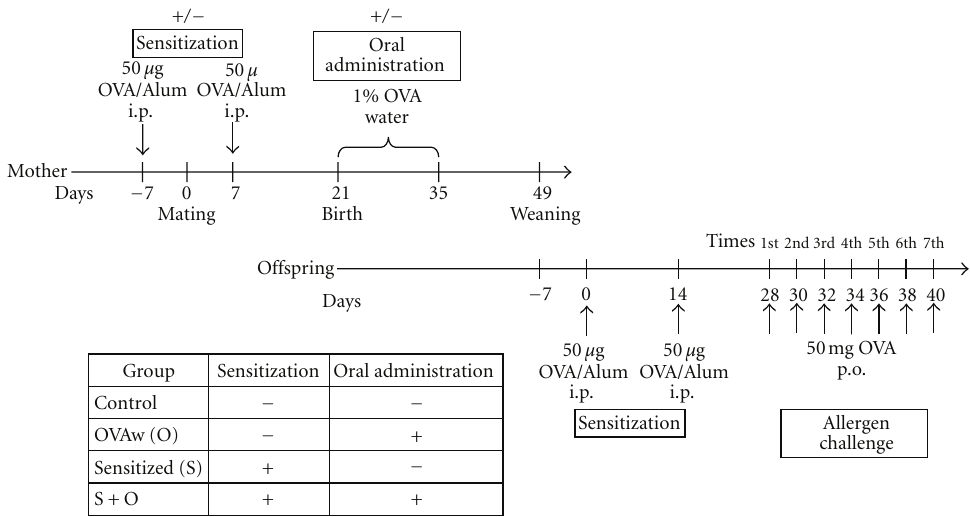
Figure 1: Experimental protocol. Sensitized mice were exposed to 1% OVA in drinking water for 2 weeks immediately after delivery. O ff spring were weaned at 4 weeks and 5-week-old o ff spring were used for the FA